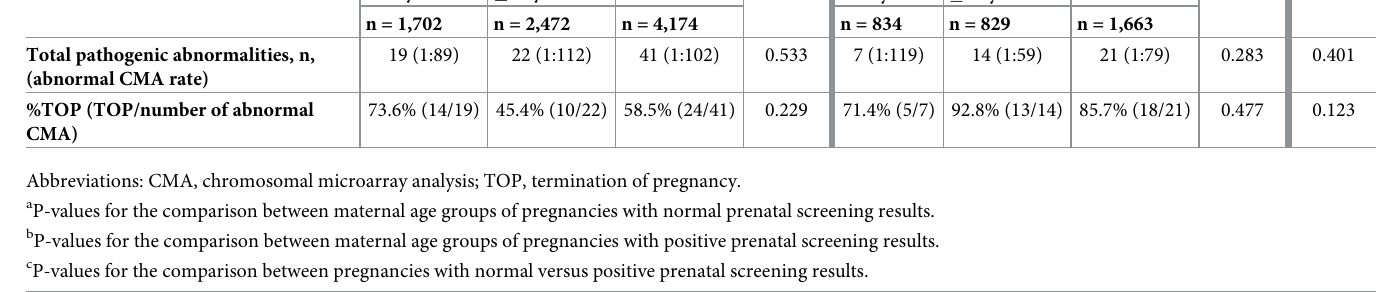
Table 2. Abnormal CMA results and elective termination of pregnancies by maternal age in pregnancies with normal or positive prenatal screening results and nor- mal karyotype (n = 5,837). Pregnancies with normal prenatal screening results